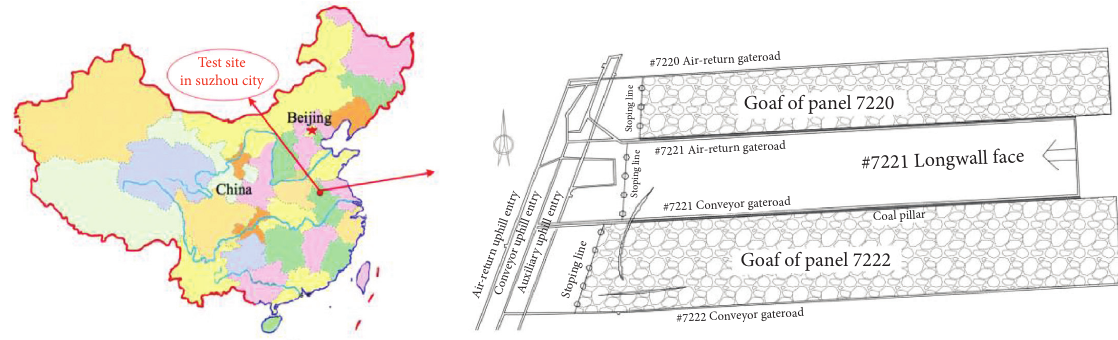
Figure 3: Mine location and layout drawing of the experimental roadway.